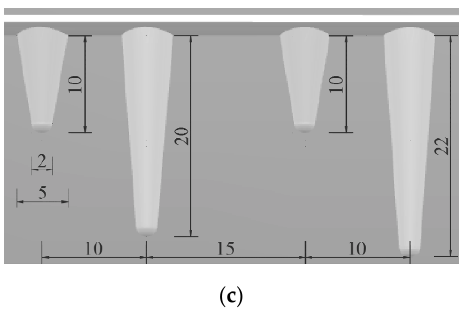
Figure 23. Side views and sizes of icicles (mm): ( a ) pipeline with crescent-shaped ice, ( b ) pipeline with D- and sector-shaped ice, and ( c ) guardrail with crescent-shaped ice.